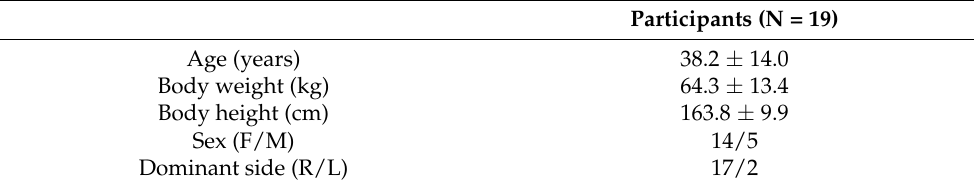
Table 1. Demographic